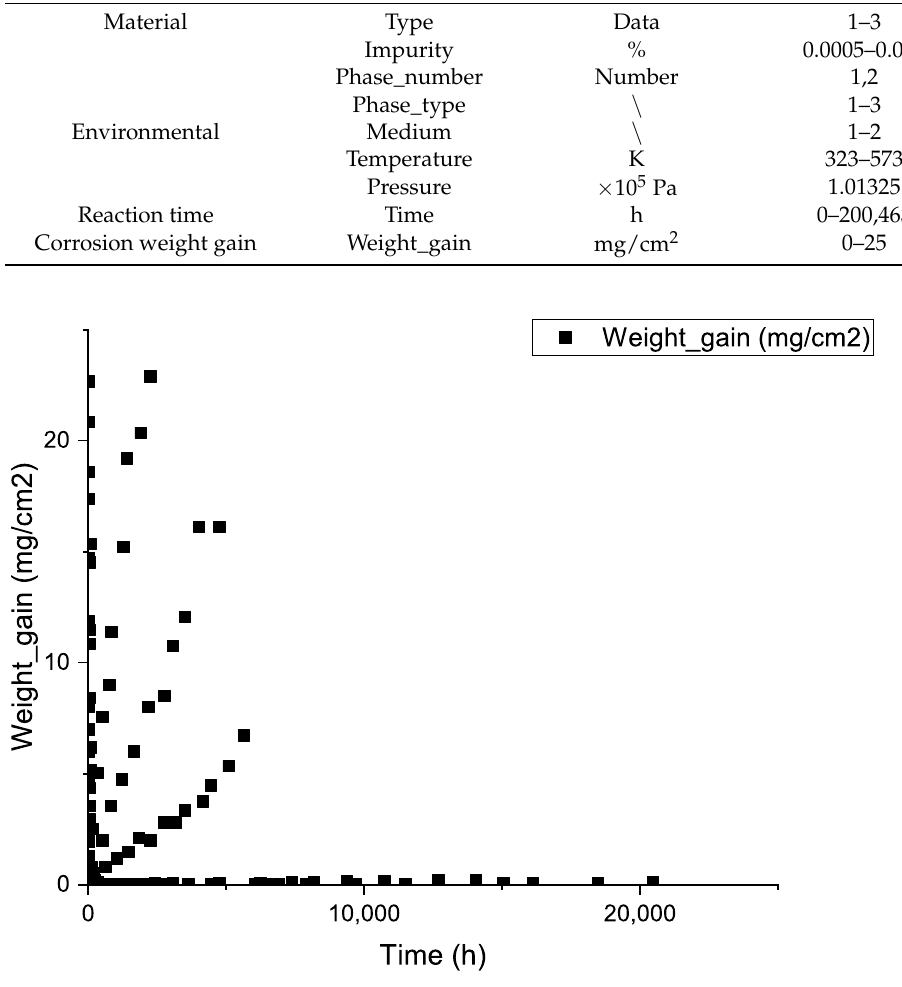
Figure 1. Scatter plot of corrosion weight gain over time for initial data.